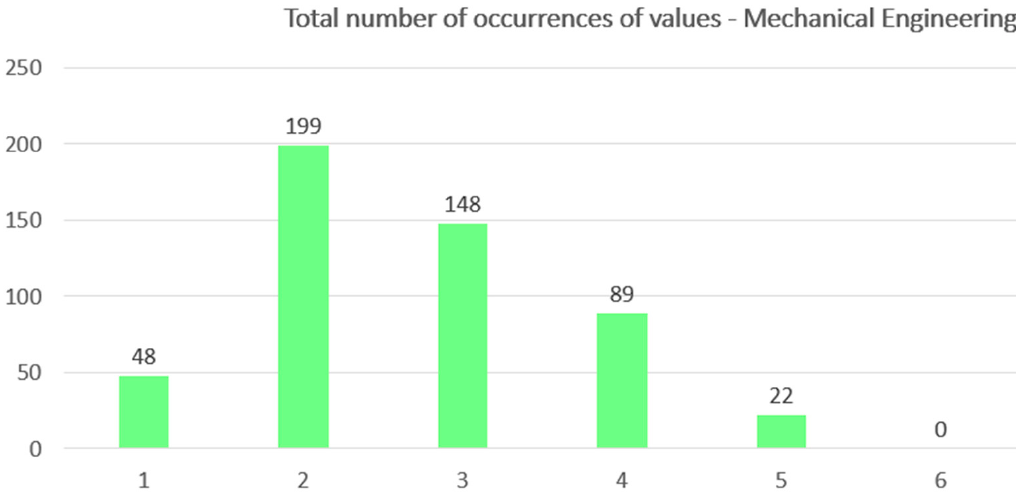
Figure 11. Total number of occurrences of values—mechanical engineering.